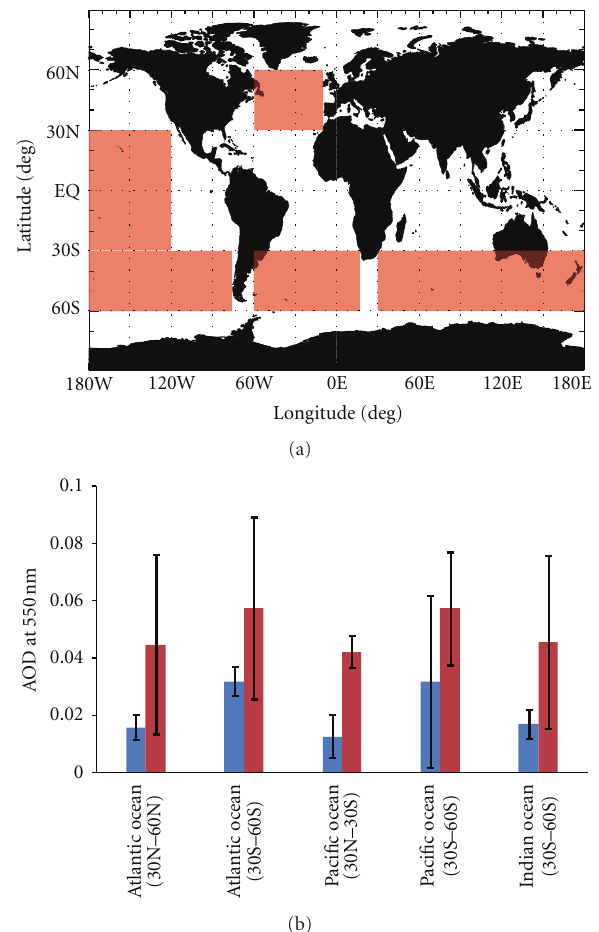
Figure 8: Comparison of MODIS AOD retrievals with model results. Retrieved MODIS AOD (red bars), modeled total AOD- S1 (blue bars), at selected marine locations: Atlantic Ocean (60N,60 W–0 N,10W), Atlantic Ocean (30S,60 W–60 S,15 E), Pacific Ocean (30 S,180 W–60 S,75 W), Pacific Ocean (30N,180 W– 30S,120 W) and Indian Ocean (30S,30 E–60S,180